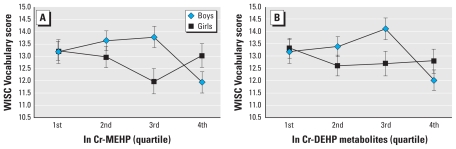
Adjusted mean WISC Vocabulary score estimated by MEHP (A) and DEHP metabolites (B) quartiles of ln creatinine (Cr)-corrected urine concentrations. Adjusted means differed significantly between the second and fourth quartiles and between the third and fourth quartiles of ln creatinine-corrected MEHP and ln creatinine-corrected DEHP metabolites for boys (p < 0.05). Among girls, there were no significant associations between these variables. Estimated means are adjusted for age, sex, birth weight, history of breast-feeding, residential area, paternal education, SES, and maternal IQ. Error bars are SEs.